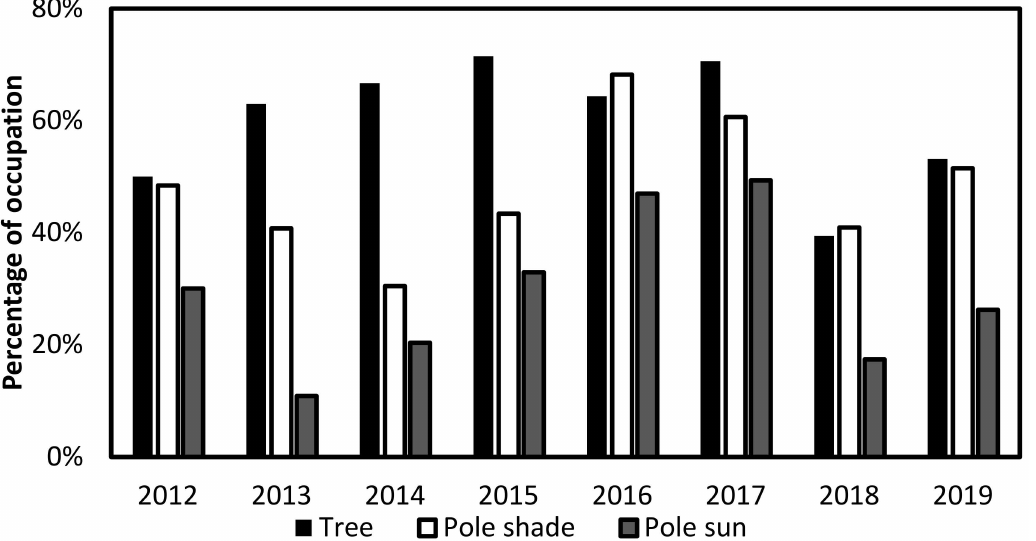
Figure 1. The percentage of occupation of barn owls breeding in nest boxes on trees, on poles in the shade, and on poles in the sun from 2012 to